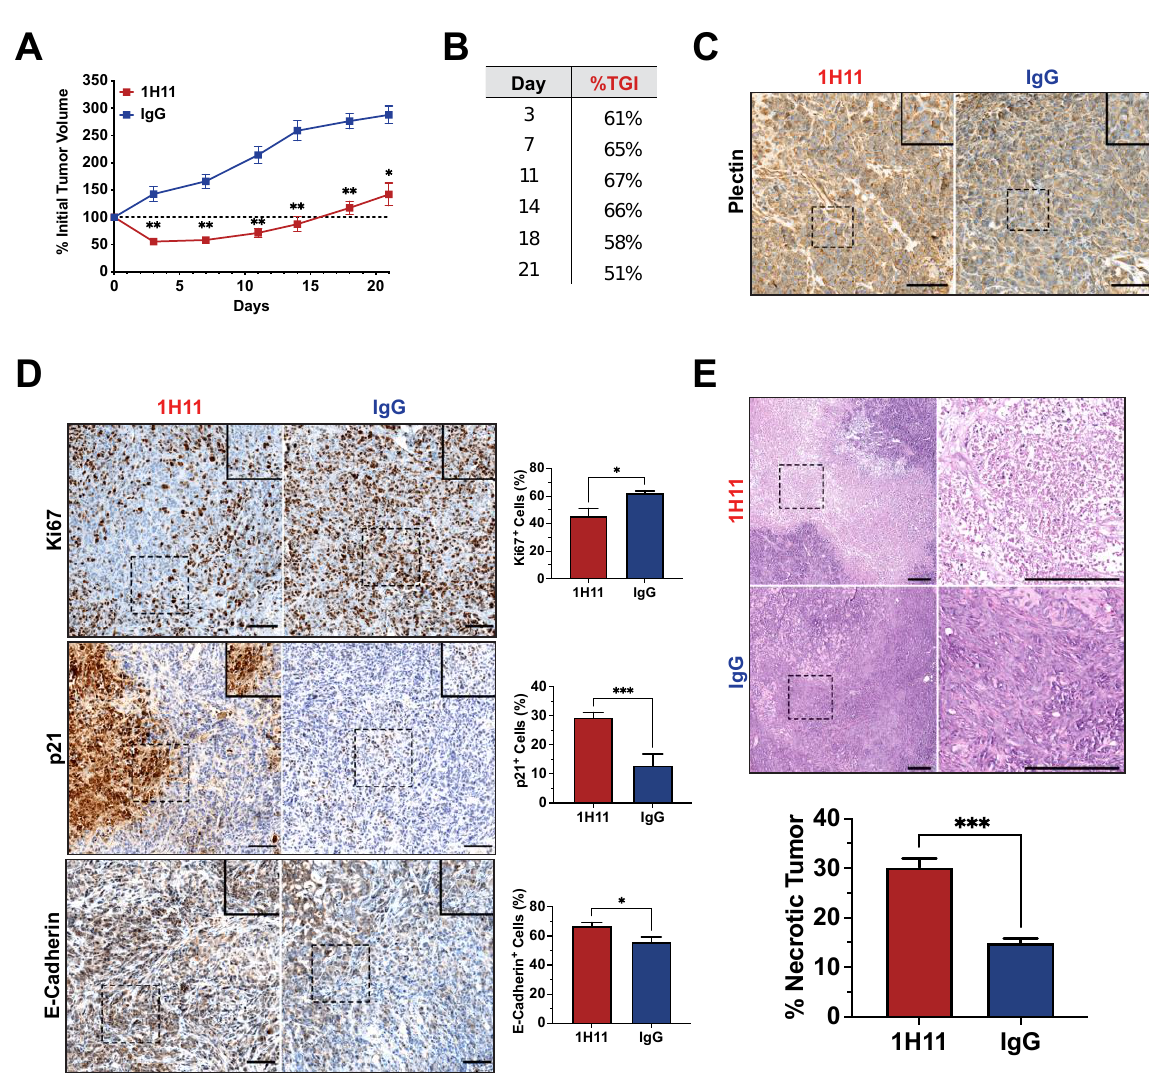
Figure 7. 1H11 reduces OC tumor growth in vivo. Athymic nude mice harboring OVCAR8 subcutaneous tumors were treated with 5 mg/kg 1H11 or IgG twice weekly then harvest after three weeks of treatment. ( A ) Tumor growth curves relative to tumor volume at day 0 and ( B ) a table of 1H11′s tumor growth inhibition (%TGI) demonstrates that 1H11 delayed tumor growth. ( C ) Representative images of IHC staining for plectin. Scale bar = 100 µm. ( D ) Representative images of IHC staining and corresponding quantification of Ki67, p21, and E-cadherin. 1H11 prompted an anti-proliferative response. Scale Bar = 100 µm. ( E ) Tumor sections were H&E-stained and analyzed for necrosis. 1H11-treated tumors had a higher percent of necrosis. Representative images are shown. Scale bar = 250 µm. For all images, scale bars are on the lower right, and dashes boxes are zoomed-in regions. All data plotted as mean ± SEM. *** p < 0.001, ** p < 0.01, * p < 0.05 vs. IgG.